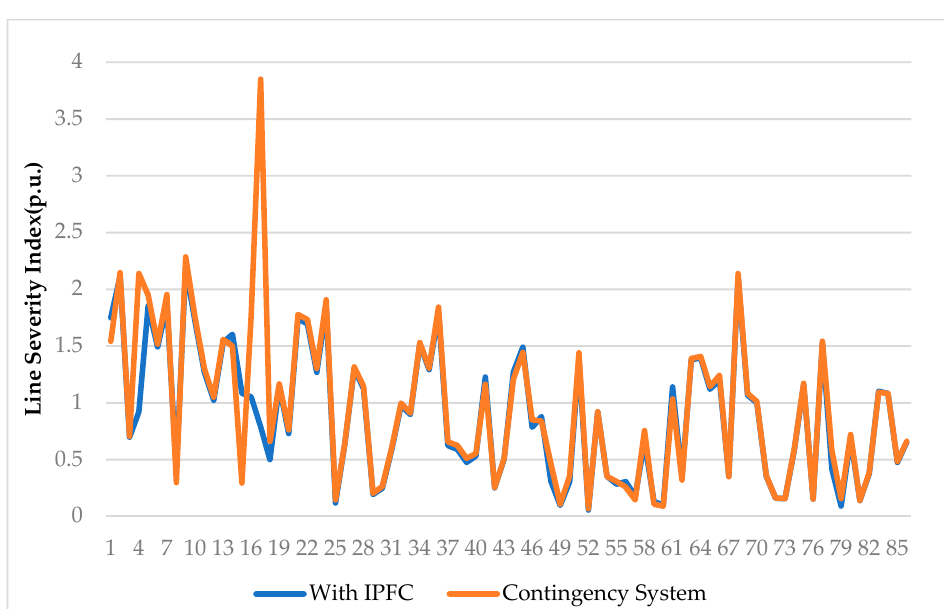
Figure 10. Line Severity Index of the Indian Transmission System.